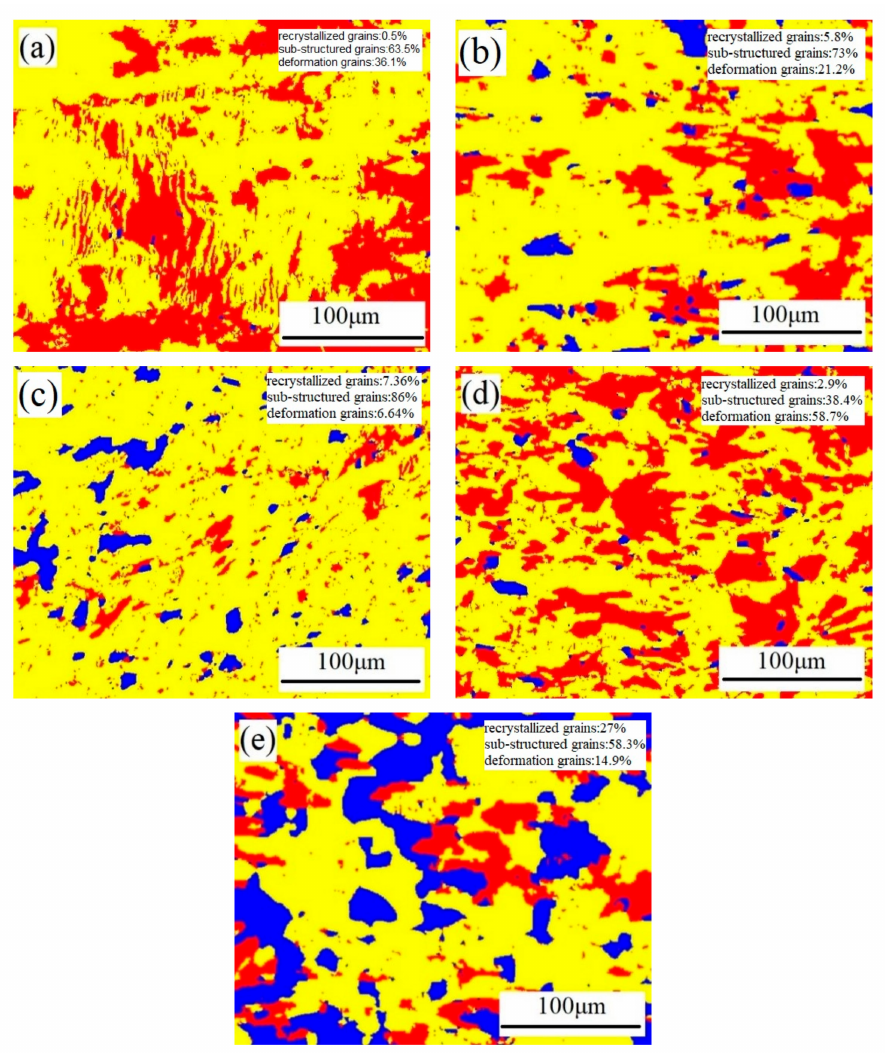
Figure 6. Microstructures of the recrystallized of 7085 and TiC / 7085 after 80% rolling deformation ( a ) 7085; ( b ) 0.1 wt% TiC / 7085; ( c ) 0.3 wt% TiC / 7085; ( d ) 0.5 wt% TiC / 7085; ( e ) 1 wt% TiC /